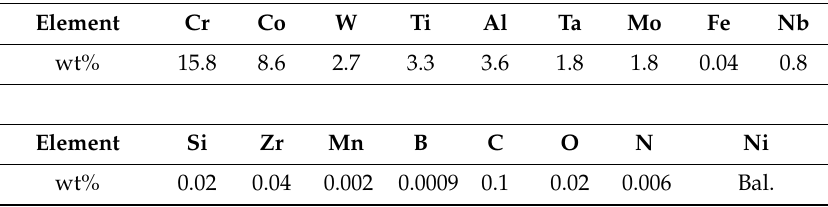
Table 1. Composition of the IN738LC superalloy used for